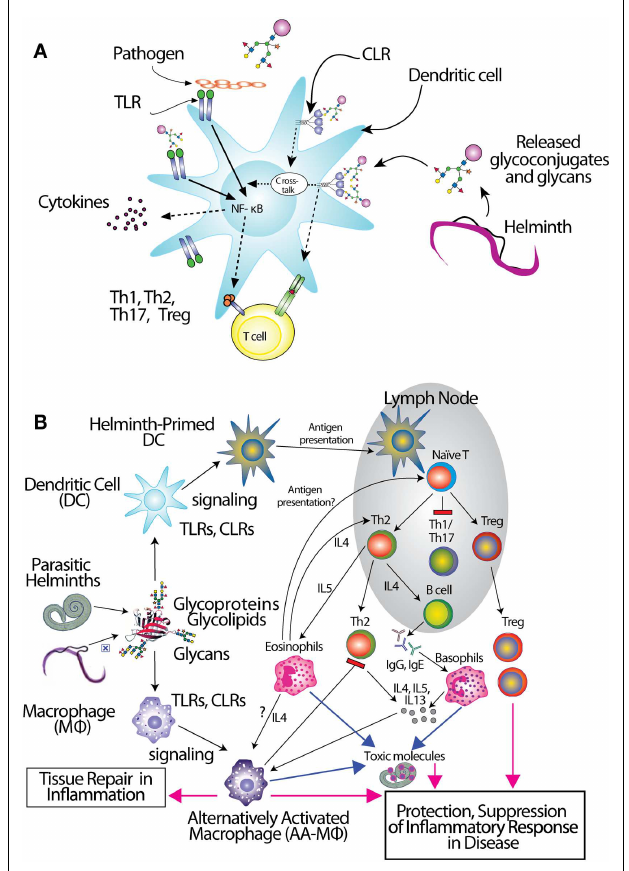
FIGURE 1 | Interactions of glycans with immune cells and regulatory pathways . (A) Glycan-binding proteins such as the C-type lectin receptor (CLR) DC-SIGN in cooperation withToll-like receptors (TLR), such asTLR4, regulate dendritic cell responses to parasite glycans. (B) Schematic representation of the role of dendritic cells (DC) and macrophages (M Φ ) in inducing an anti-inflammatory adaptive immune response upon contact with helminth